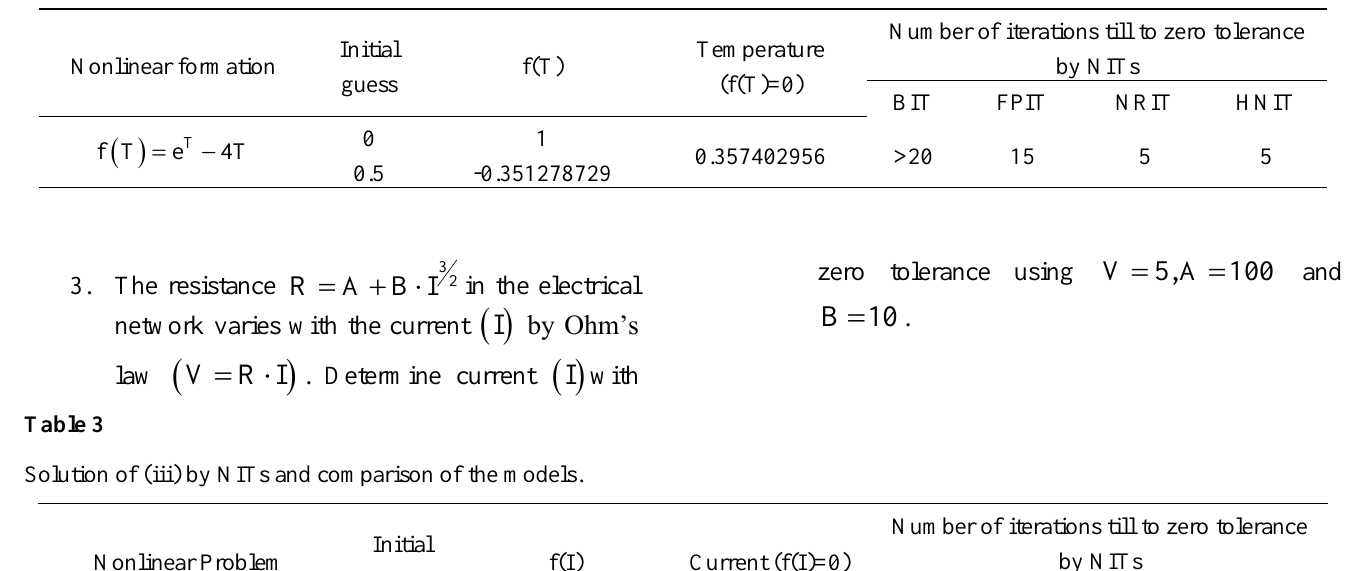
Solution of (ii) by NITs and comparison of the models.